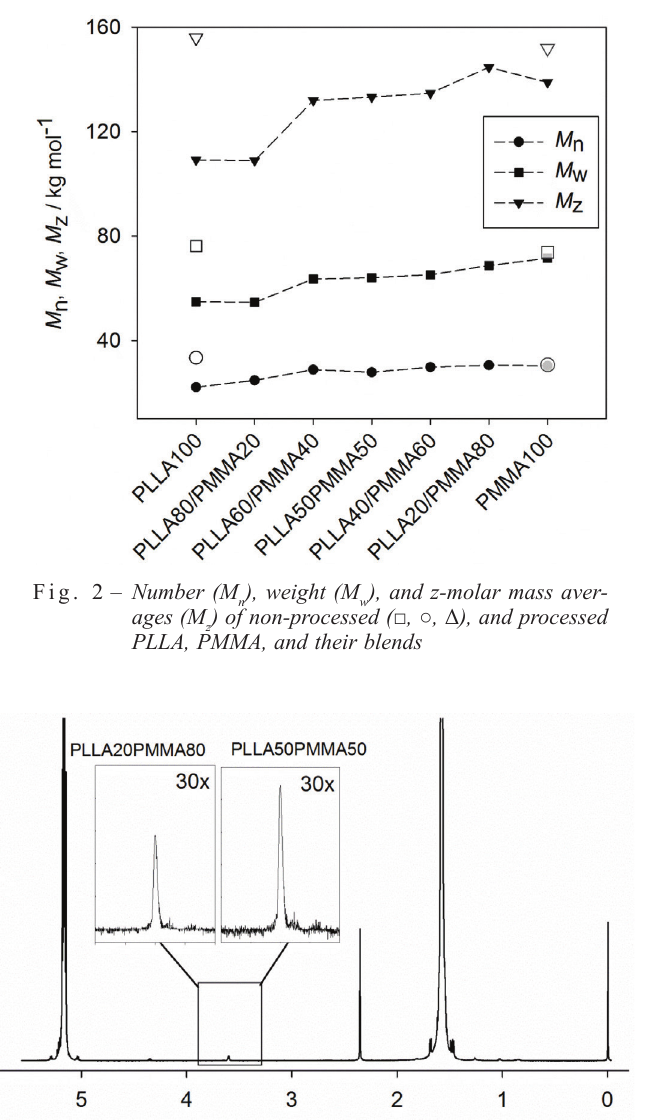
Fig. 3 – NMR spectra of separated PLLA20 and PLLA50 from PLLA20/PMMA80 and PLLA50/PMMA50 by dissolving and separating PMMA